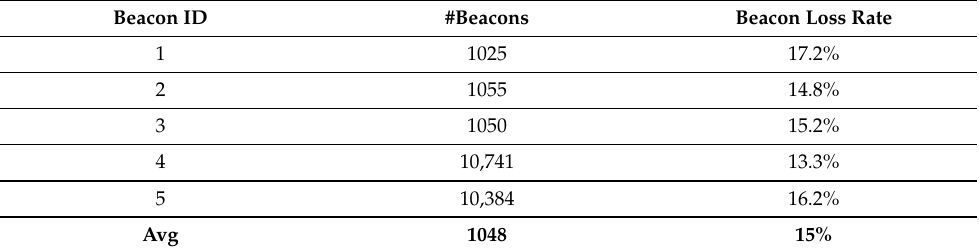
Table 6. Results of calibration test T 8 .